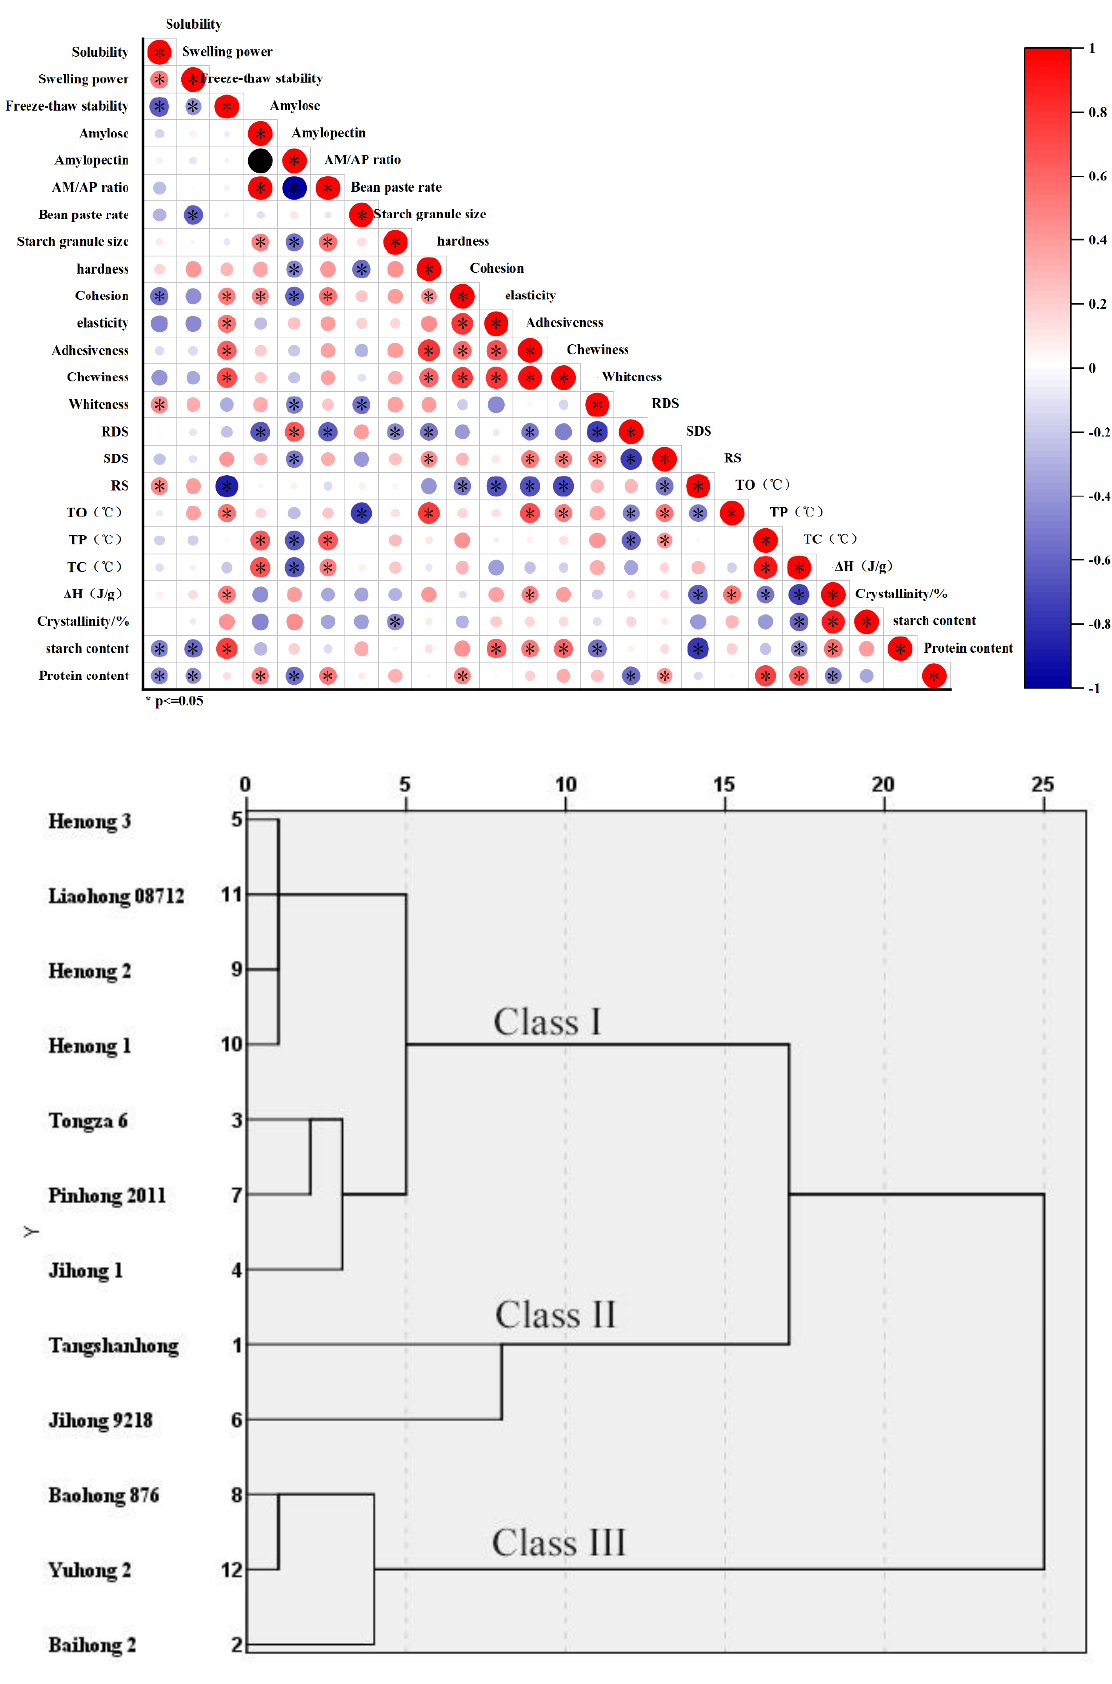
Figure 6. Correlation and cluster analysis of starch characteristic indices in different adzuki bean varieties.